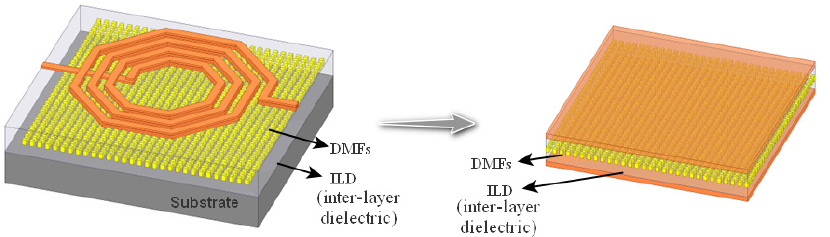
Figure 2. Schematic diagram of the equivalent flat capacitor model, with the original inductor containing DMFs on the left and the equivalent flat capacitance containing the same DMF process on the right.